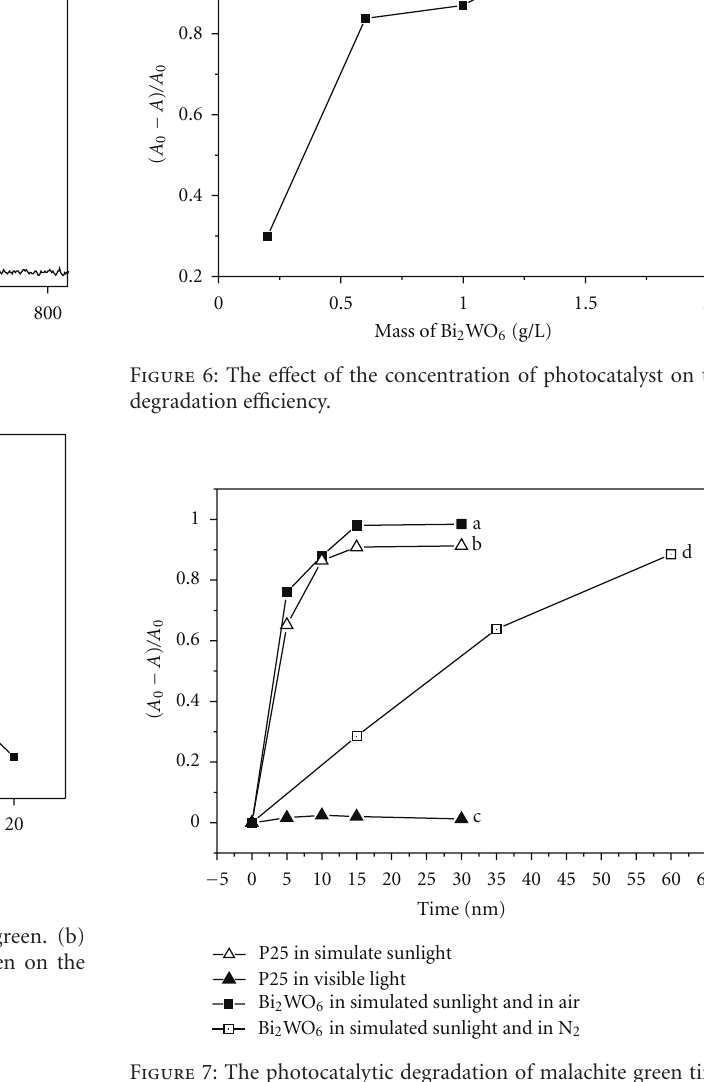
Figure 7: The photocatalytic degradation of malachite green time under optimal conditions (the initial concentration of malachite green, initial pH value, and the concentration of photocatalyst are 10mg · L − 1 , 2, and 1.0g · L − 1 , resp.): (a) Bi 2 WO 6 under Xe lamp (as indicated by black square; (b) reference P25 under Xe lamp (as indicated by white triangle, simulated sunlight); (c) reference P25 under visible light (as indicated by black triangle); (d) Bi 2 WO 6 under visible light and anoxic